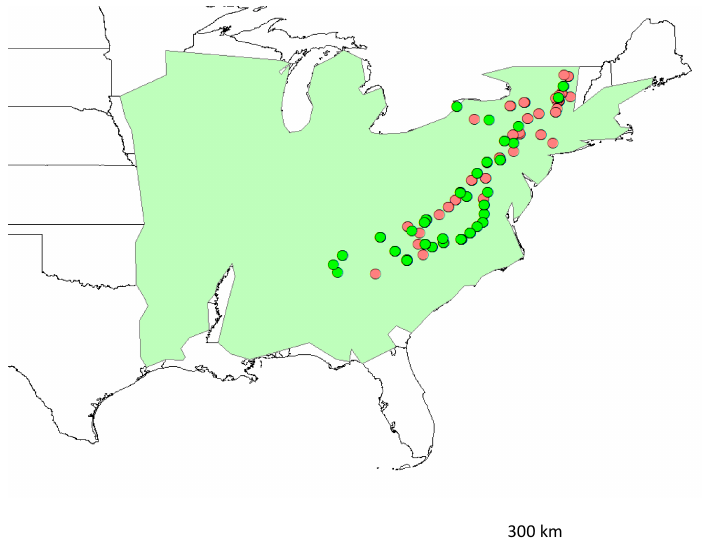
Figure 1. Map of collection sites, showing those where acorns of red oak ( Q. rubra , red dots) and white oak (Q. alba , green dots) were sampled. Efforts were made to collect from the same trees each year between 2011 and 2019 (excluding 2018), but in many years, oaks failed to produce acorns. Green shaded area is the approximate distribution of Q. alba in U.S. Q. rubra is distributed over approximately 95% of the same area except in some areas of the far southeast and southwest of Q. alba distribution.